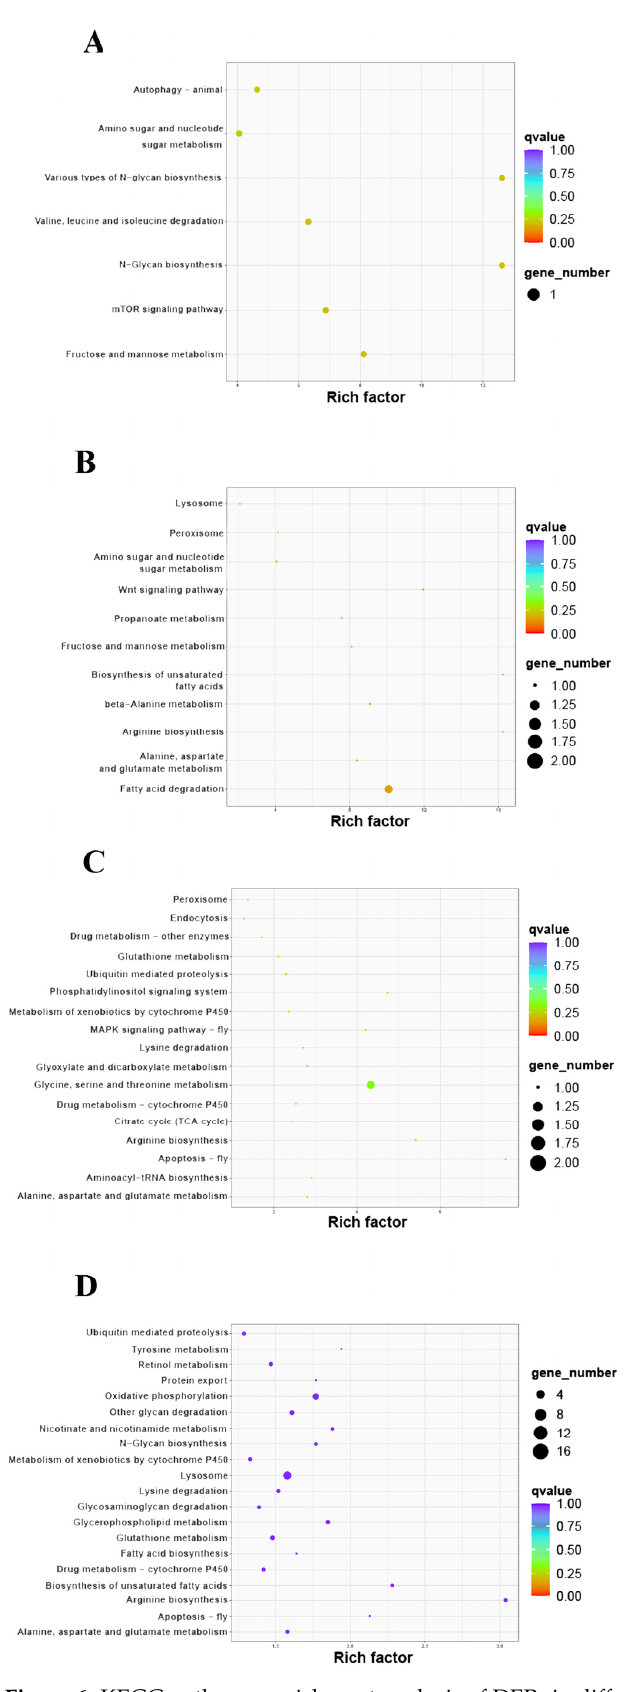
Figure 6. KEGG pathway enrichment analysis of DEPs in different comparison groups. ( A ) HE-I vs. HE-II, ( B ) HE-II vs. HE-III, ( C ) HE-III vs. HE-IV, ( D ) HE-IV vs.